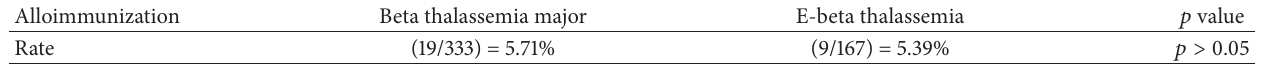
Table 1: Alloimmunization in different types of thalassemic patients.